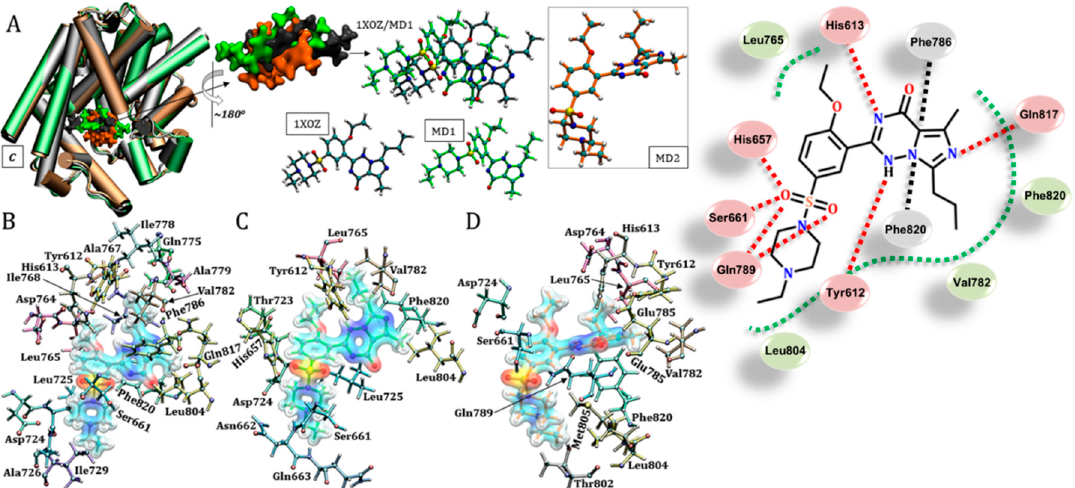
Figure 6. Positions of the vardenafil ligand obtained for the three protein structures studied. ( A ) shows the position similarity obtained for vardenafil in the 1XOZ and MD1 structures. ( B ) Shows the residues in the crystallographic structure that stabilize the ligand, while ( C ) and ( D ) show the residues responsible for inhibitor stabilization in the catalytic site considering structures MD1 and MD2, respectively. Residues were r ≤ 3.0 Å from the ligand. Legend of interactions, red: hydrogen bond (and dipole–dipole); green: hydrophobic; black: π -stacking.